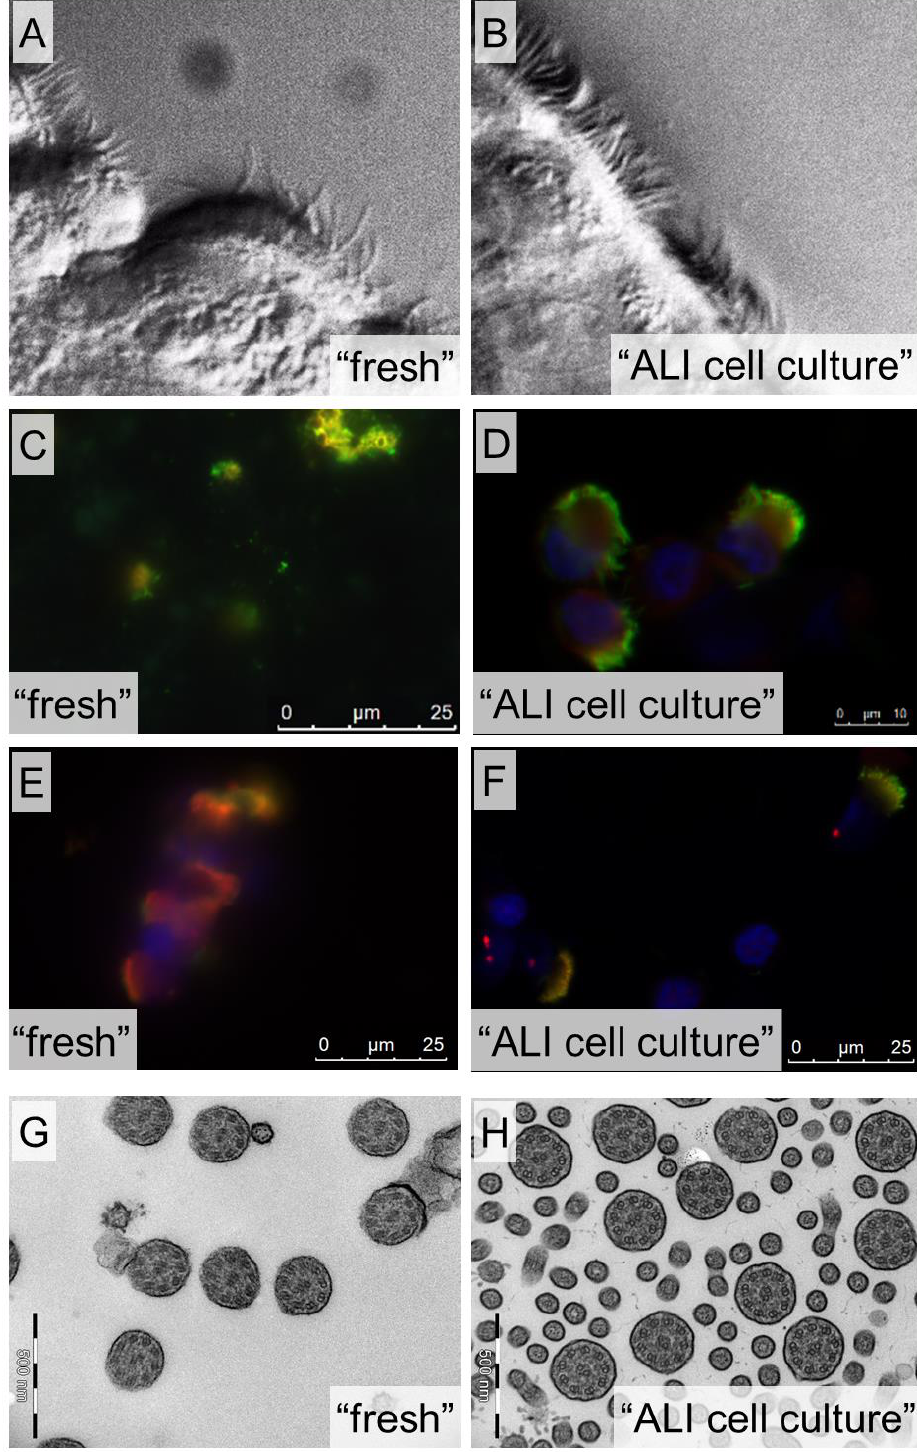
Figure 4. Examples of quality differences between fresh and ALI cell culture samples for HSVM ( A , B ), IF ( C – F ), and TEM ( G , H ). In C – F , the green staining shows the tubulin of the ciliary axoneme, the red staining shows the GAS8 ( C , D ) or DNAH5 ( E , F ) protein, and the blue staining the cell nuclei. We performed TEM analysis for 30 cases ( n = 4 only fresh, n = 3 fresh and ALI, n = 23 only ALI). There was “no evidence for PCD” in 22 cases (72%). Six cases were positive for PCD: four cases (14%) showed a class 1 ODA and IDA defect, one (3%) a class 1 microtubular disorganization and IDAs defect, and one (3%) a class 2 ODA defect.